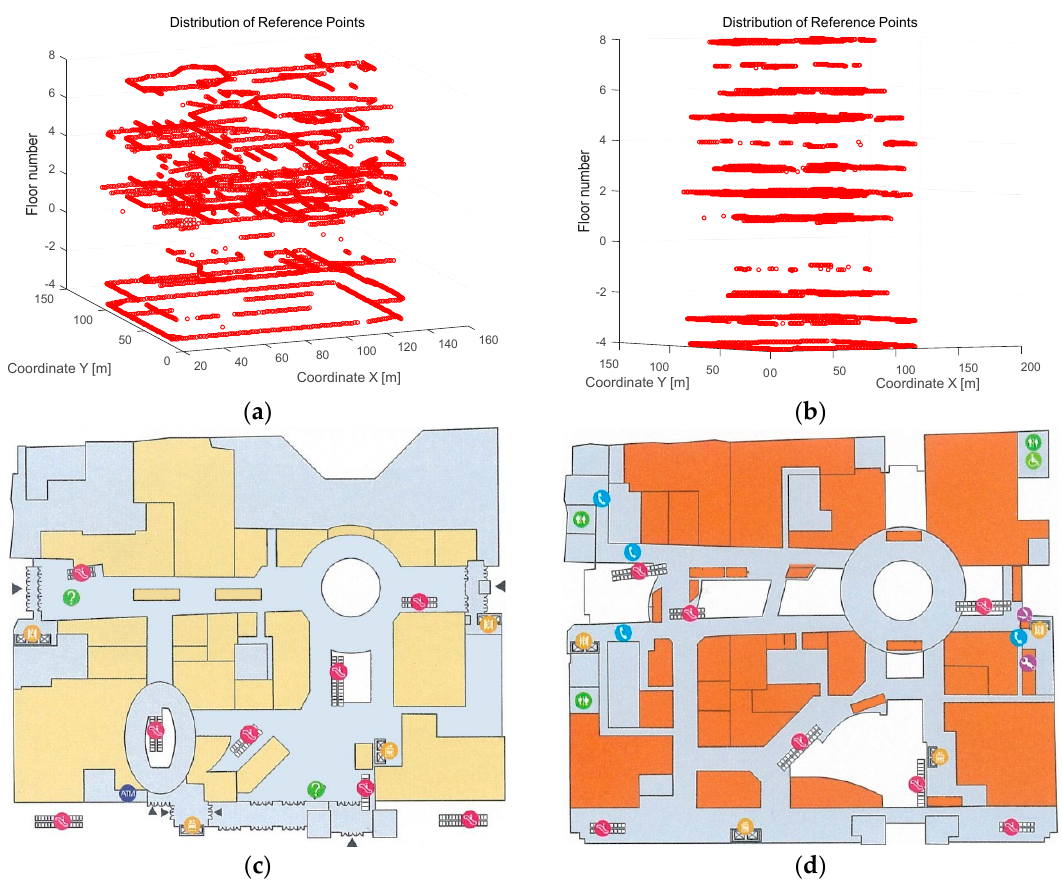
Table 2. Distribution of RPs and the number of APs at 12 floors in Test-bed 2.